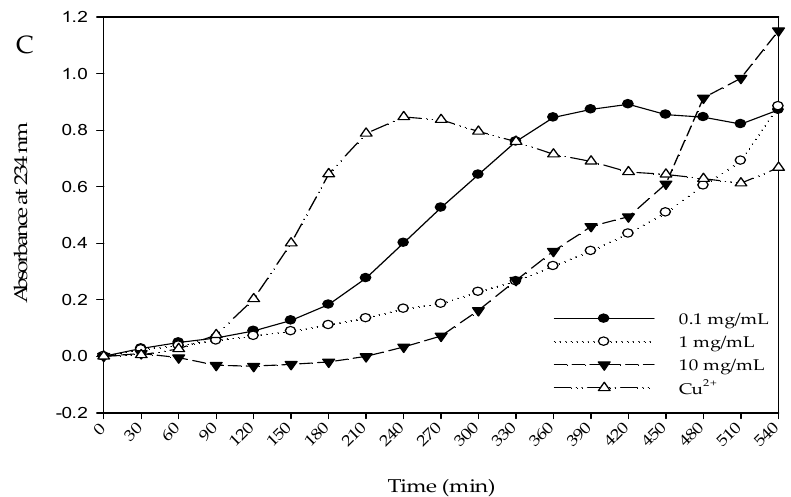
Figure 5. Effects of WPH and WPH fractions on Cu 2+ -mediated conjugated diene formation in low-density lipoprotein (LDL). LDL (100 μ g protein/mL) was incubated with 10 μ M CuSO 4 at 37 °C in the absence or presence of WPH and WPH fractions. Conjugated diene was used to measure the absorbance at 234 nm every 30 min for 540 min and the results express relative absorbance at 234 nm.